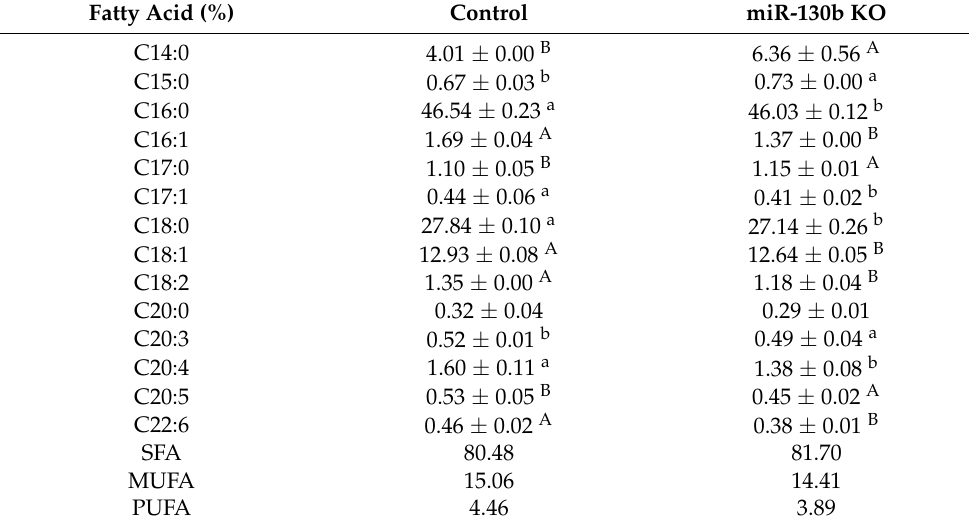
1 Fatty acid data are expressed as the ratio of total fatty acids detected in cells. Statistical significance of the difference between miR-130b knockout (KO) and corresponding control GMEC is as follows: p < 0.05 and p < 0.01 are shown as lower case letters and upper case letters, respectively. Data are shown as mean ±